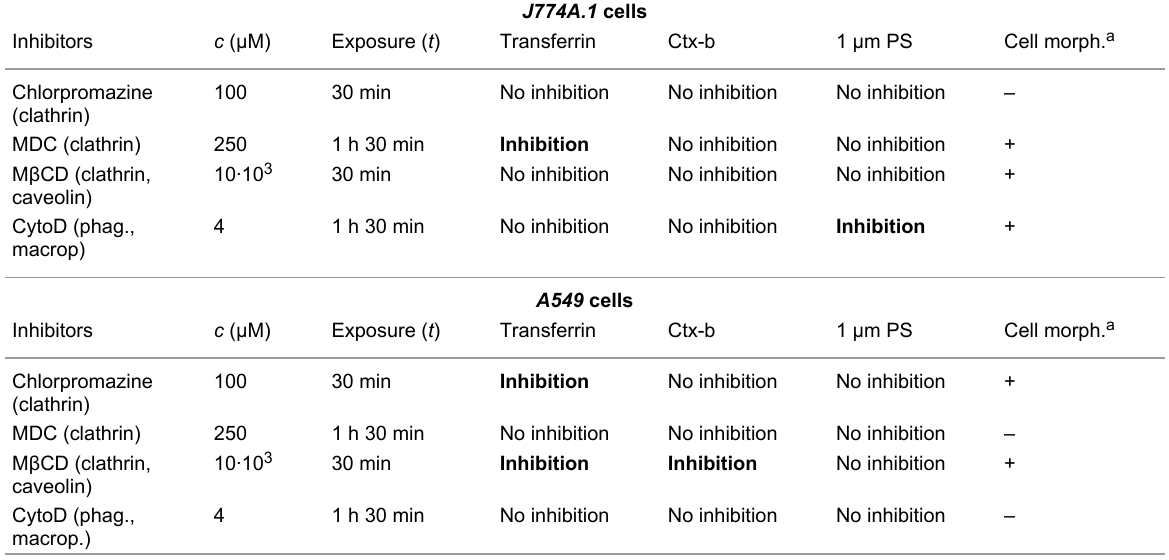
Table 1: Analysis of the different endocytotic inhibitors regarding specificity and efficiency.